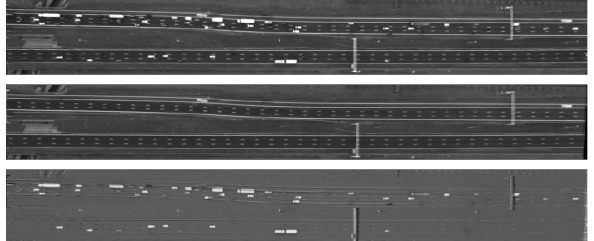
Figure 2: The difference image (bottom) is obtained by subtract- ing the background image (middle image) from the top image.